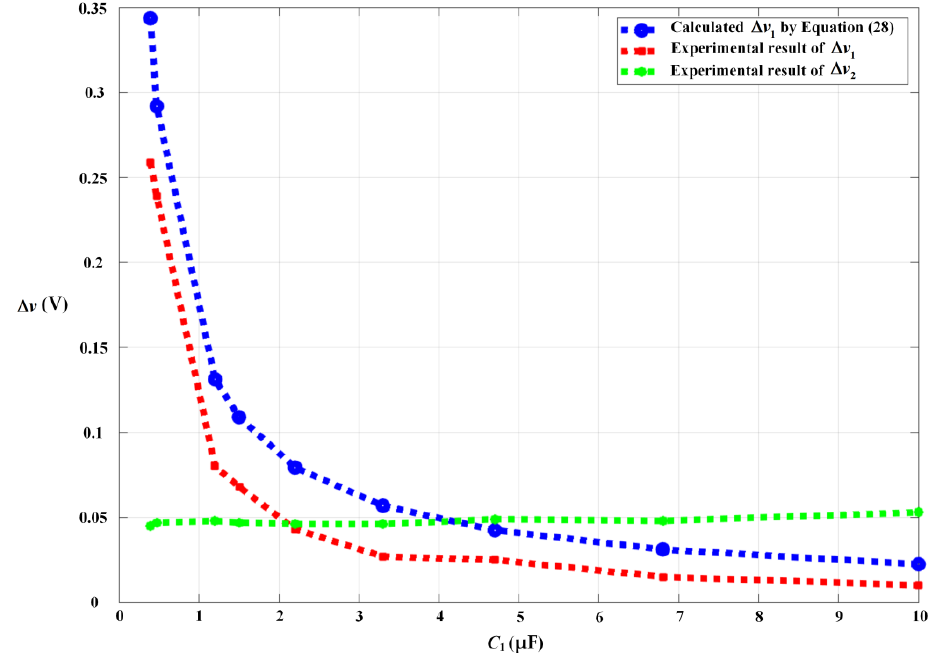
∆ v ∆ v 1 and 2 according to C 1